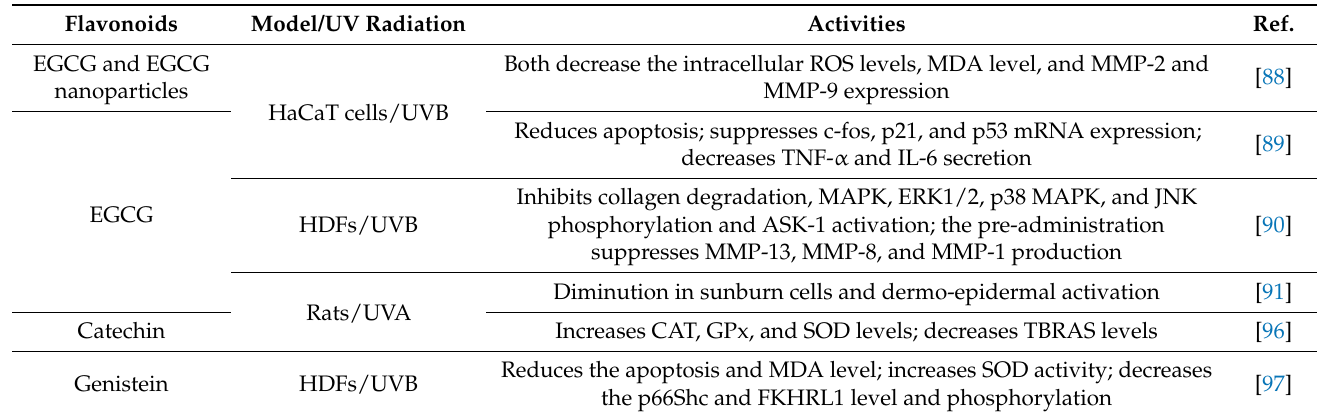
Table 4. Main anti-photoaging functions of flavan-3-ols and